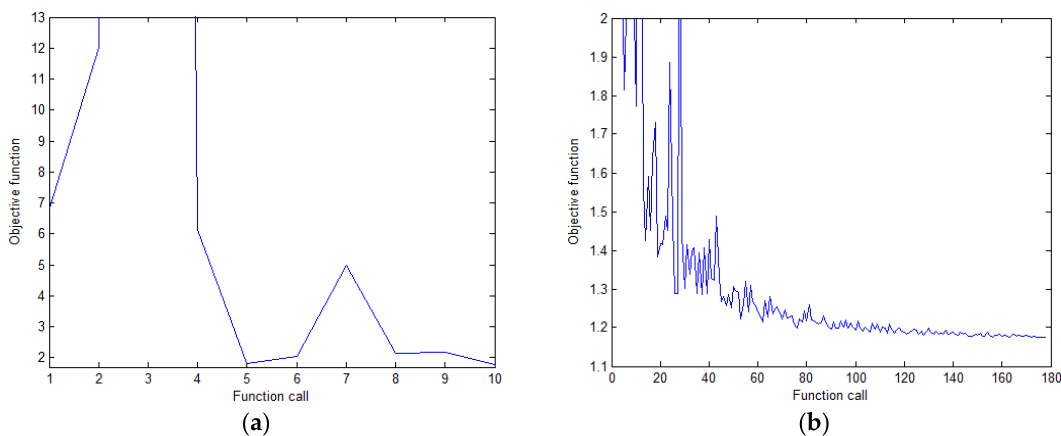
Figure 6. The objective function change during building of the simplex ( a ) and during the optimization ( b ). Different scales